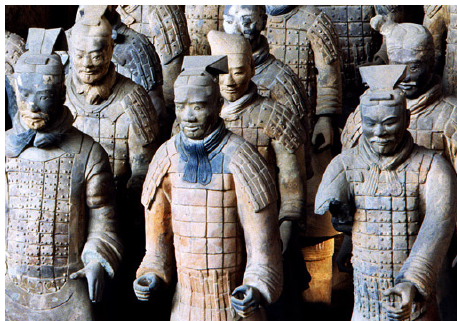
Fig 2: The terracotta army (photo: Xia Jux-